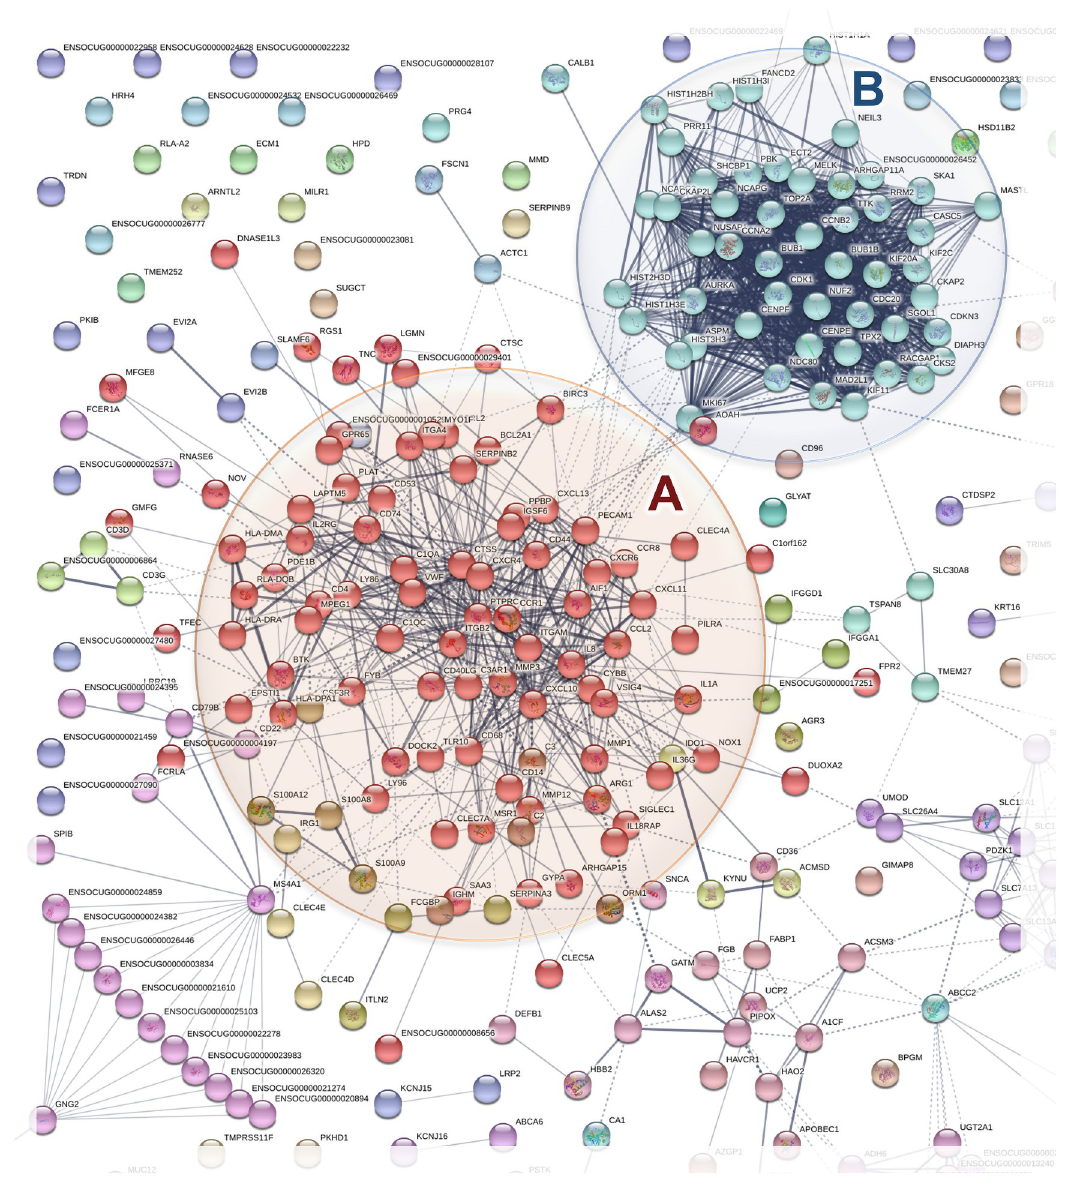
Fig 4. Clusters of immune response and cell cycle regulation in DED. Of the genes upregulated (FC > 1.5, p < 0.05) in rabbit DED, 55% were in two clusters, A (red balls), corresponding to the innate and adaptive immune response, and B , corresponding to the cell cycle regulating gene network (blue balls). The analysis was performed as in